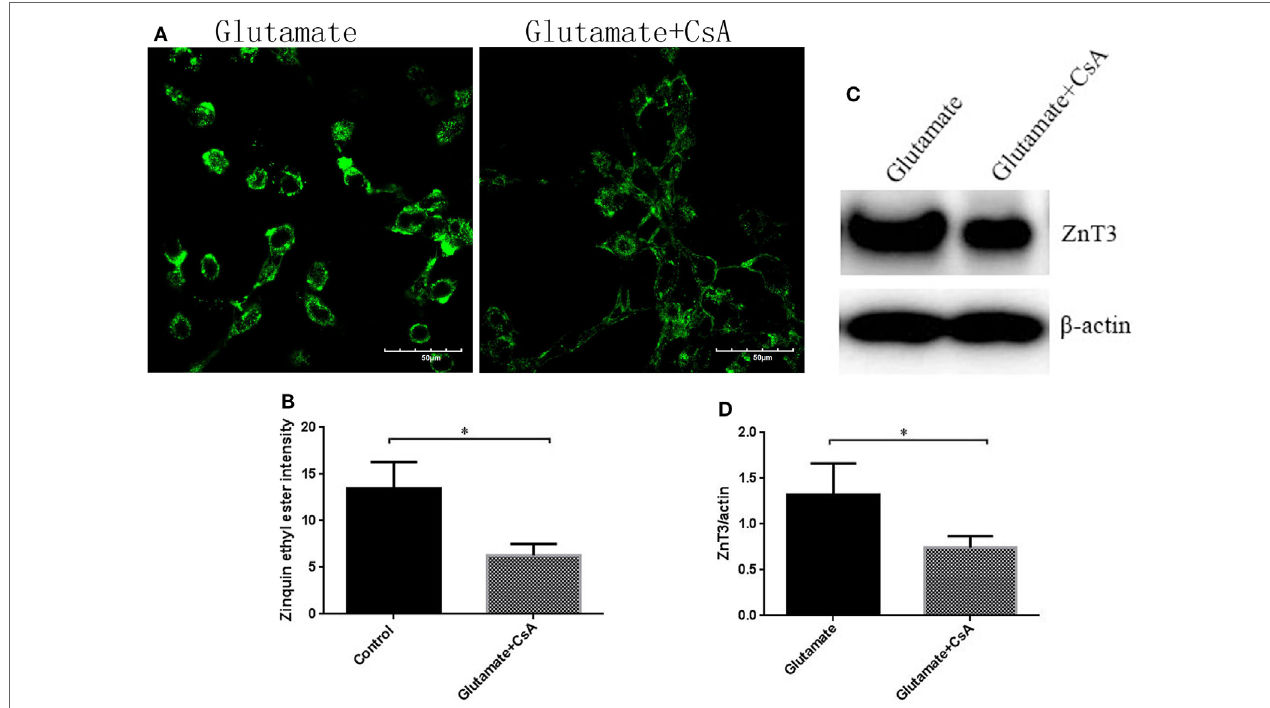
FigUre 9 | The effect of cyclosporinA (CsA) on glutamate-triggered cellular zinc disorder. (a) The fluorescence intensity of Zinquin ethyl ester in HT22 cells; (B) the quantitative analysis of the average fluorescence intensity of Zinquin ethyl ester in HT22 cells; (c) Western blot assay of zinc transporter 3 (ZnT3) in HT22 cell; (D) the relative expression (integral optical density) of ZnT3 in HT22 cells. * P < 0.05, ** P < 0.01. ns, not significant.